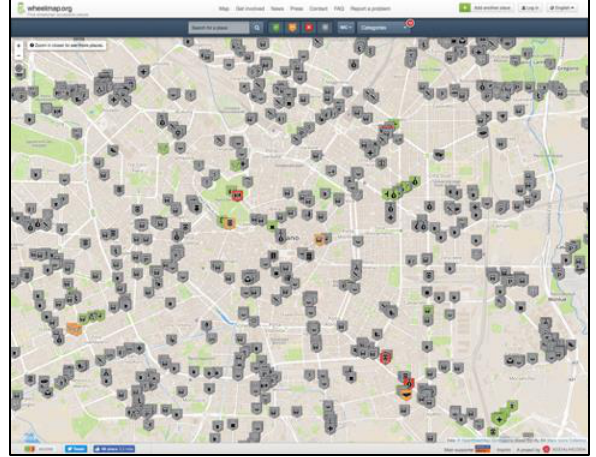
Figure 3. Screenshot of Wheelmap website. In the case of Milan (Italy), it’s possible to see how many POIs still have missing information (in grey). Source: http://wheelmap.org However, this kind of solutions still has several limitations.